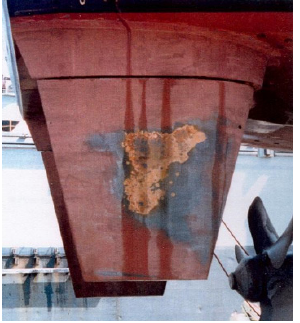
Figure 2. Erosion example of full-spade rudder (Iowa Research Online).